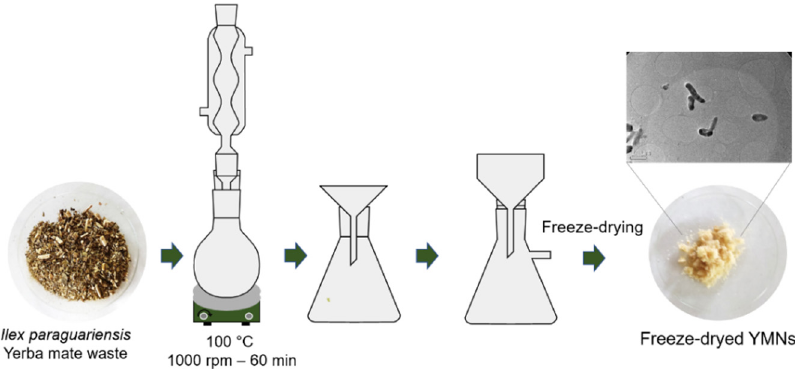
Figure 1. Schematic representation of the yerba mate nanoparticles (YMN)’ extraction from yerba mate infusion wastes.